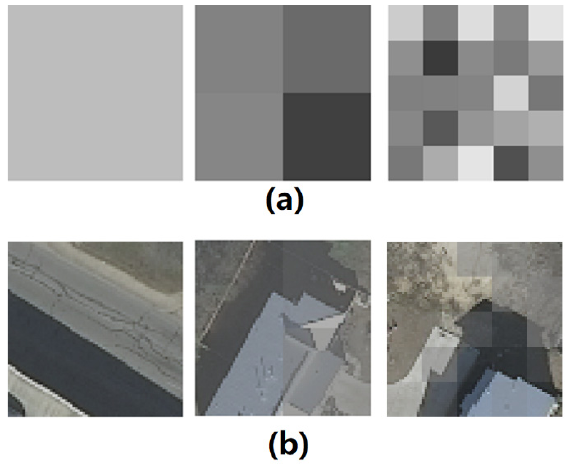
Figure 2. Multi-scale haze-image training dataset. ( a ) Distribution of the transmission of the atmosphere and ( b ) hazy image caused by the atmosphere transmission of ( a ).